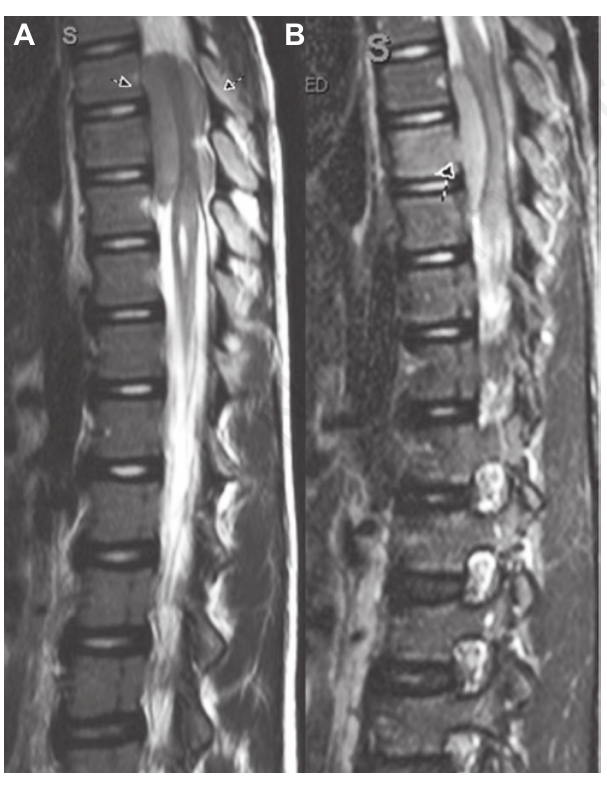
Figure 2. Sagittal T1 (A) and T2 (B) weighted images after 1 year of surgery shows fatty marrow changes involving multiple tho- racic vertebrae. Post-surgical changes of decompressive laminec- tomies are also seen. There is mild atrophy of the mid thoracic spinal cord with prominent central canal, best seen on the T2 weighted images. No residual or recurrent tumor